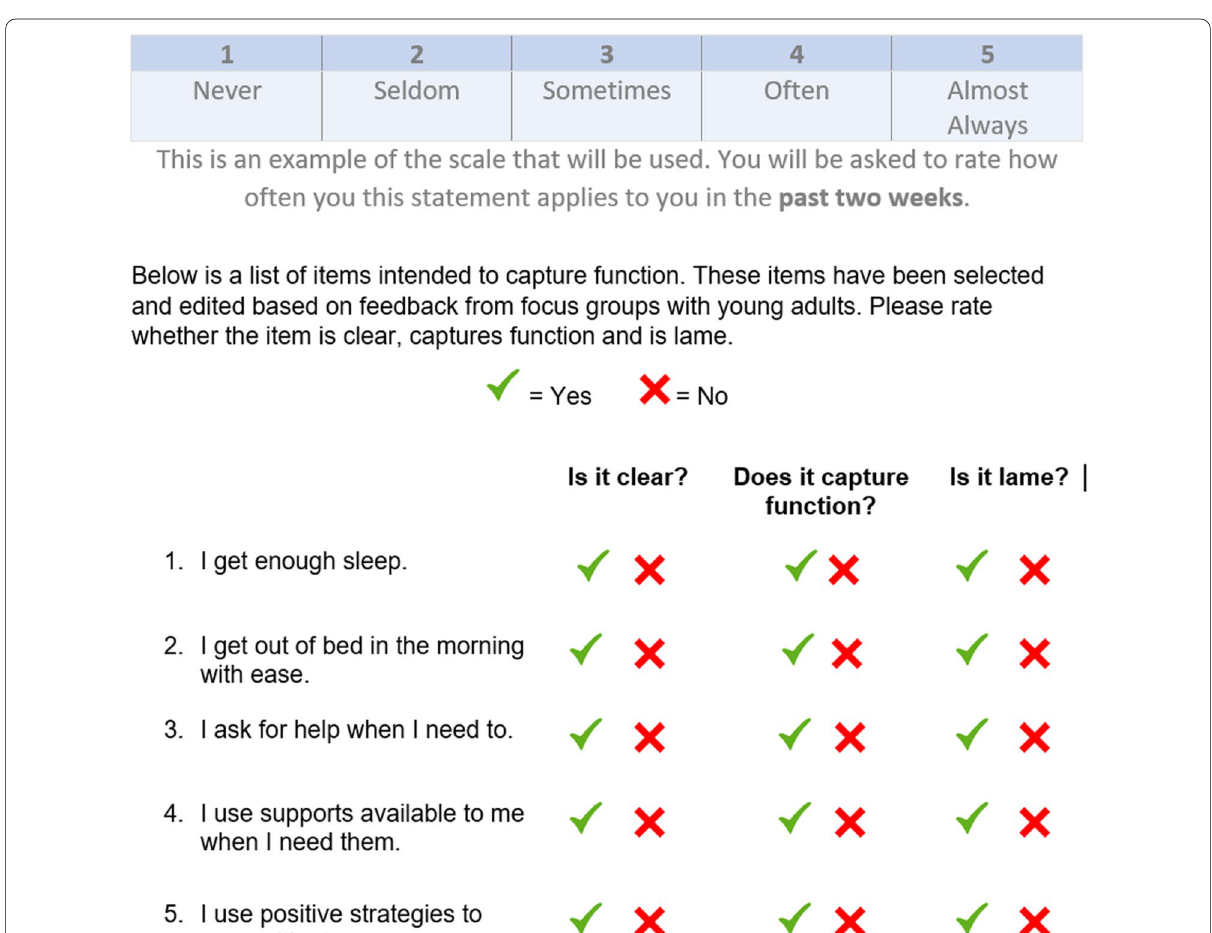
Fig. 2 Example of structure to test items in Phase